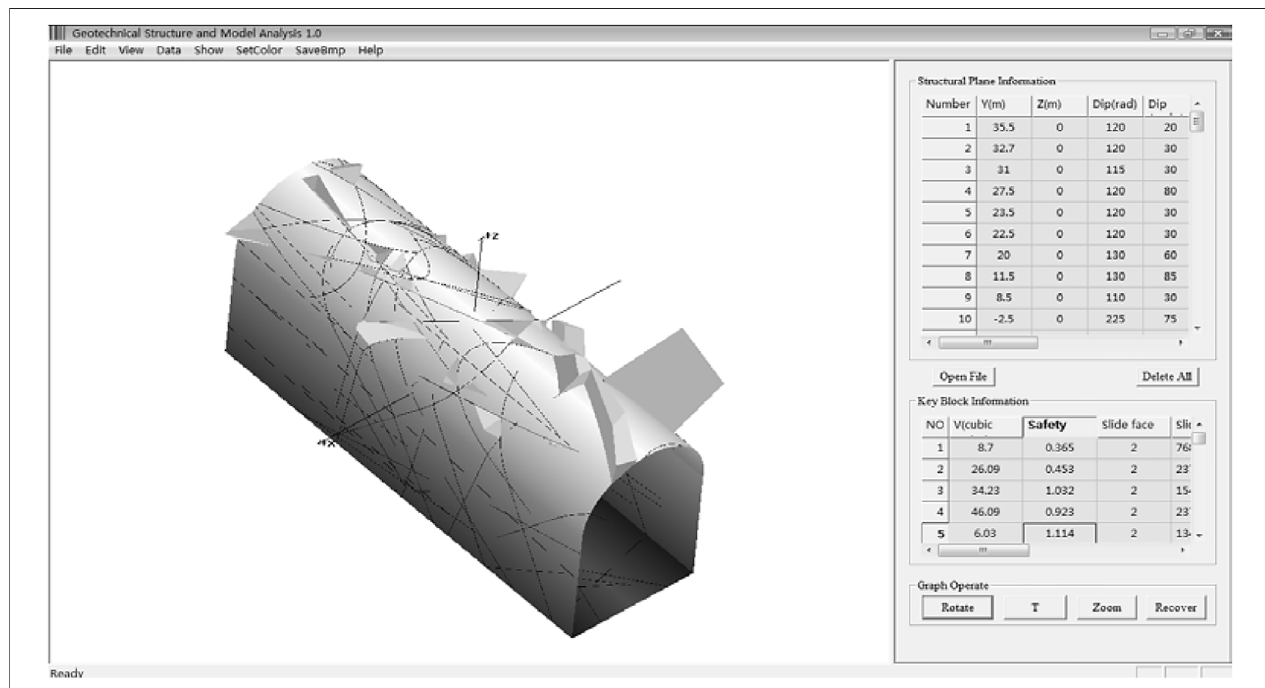
FIGURE 11 | GeoSMA-3D system.